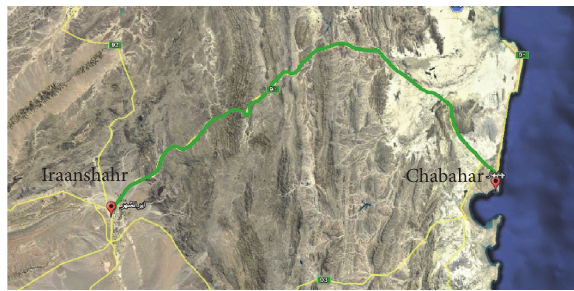
Figure 1: The Iraanshahr-Sarbaaz-Chabahar